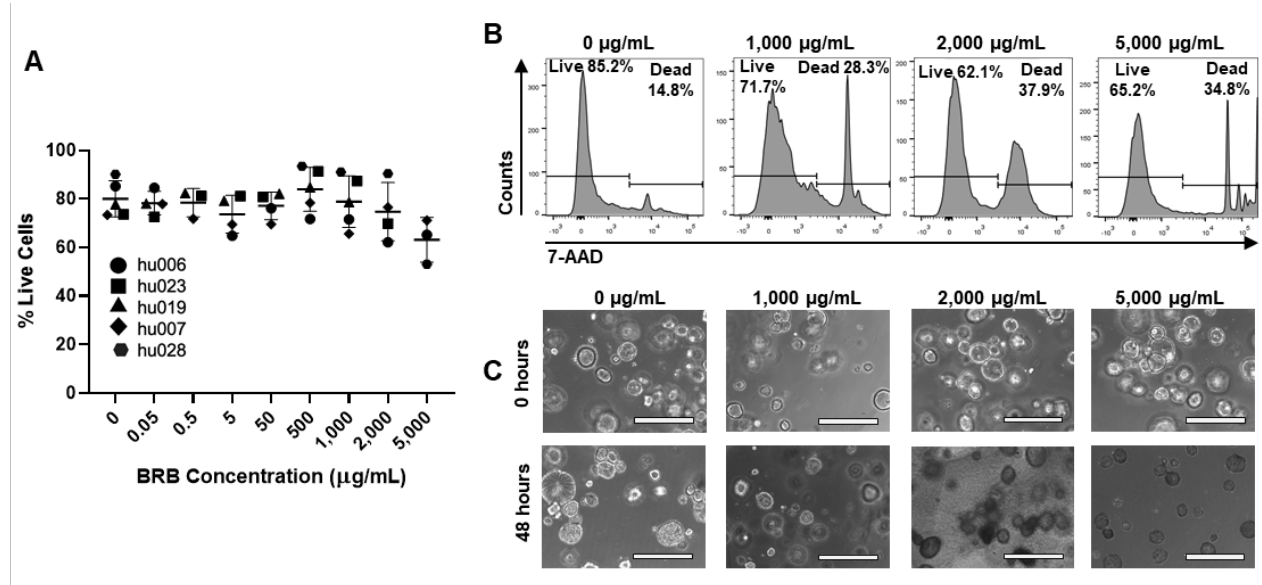
Figure 7. Toxicity analysis of BRB extract in primary human gastric epithelial cell cultures. ( A ) Gastric organoid viability following 48 h of culture in the presence of UMN-BRB extract at different concentrations. Following BRB exposure, cells were harvested by trypsinization and analyzed for 7-AAD dye exclusion by flow cytometry. Pooled data from n = 3–5 independent experiments; individual data point, mean ± SD. Differences between treated organoids and untreated controls were analyzed by ANOVA. ( B ) Representative FACS histograms for the data in ( A ) showing 7-AAD staining of gastric organoid cells. ( C ) Representative images of organoid cultures treated with UMN-BRB extract after 0 and 48 h. Bar = 400 µm.